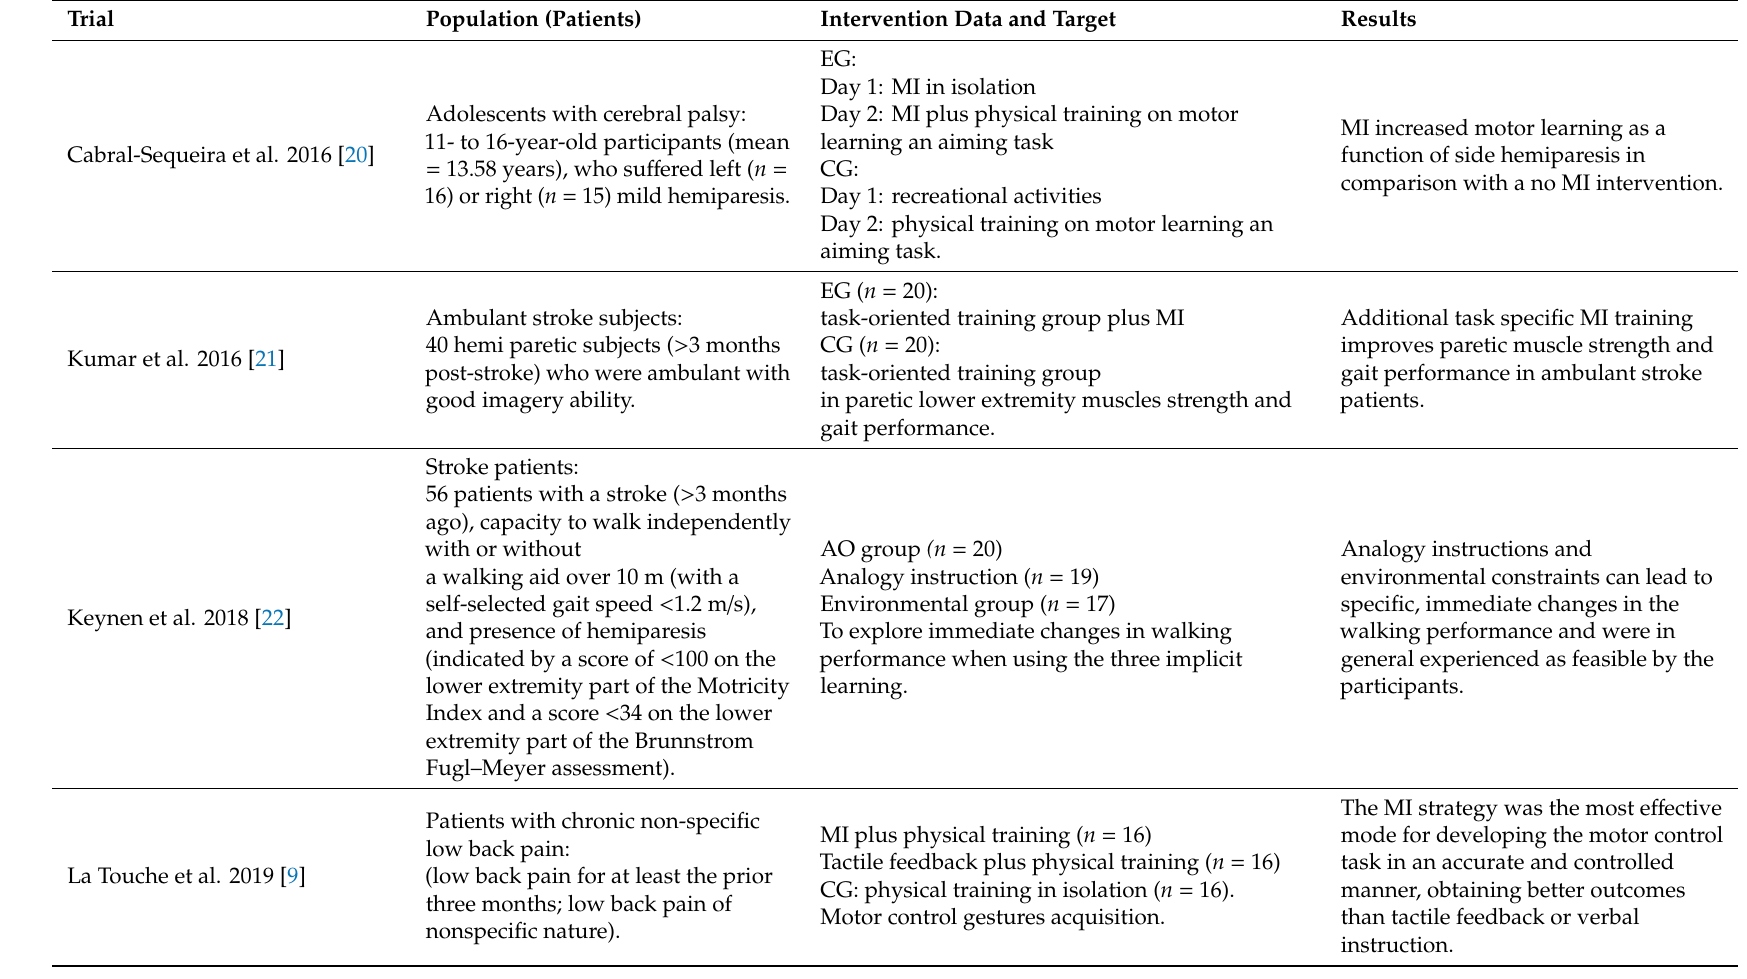
Table 1. Characteristics of the included